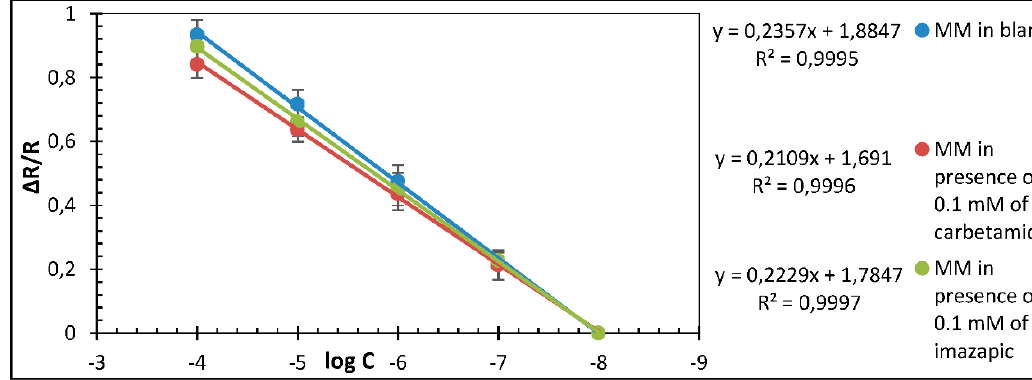
Figure 3. The calibration curves of metamitron only, metamitron in the presence of 10 − 4 M of Imazapic, and 10 − 4 M of